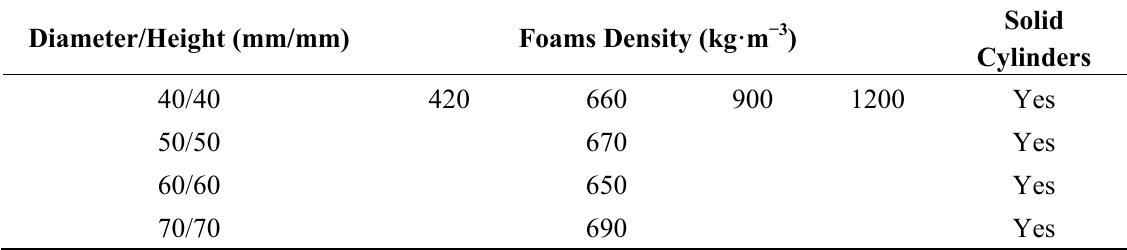
Table 1. Densities and sizes of the samples used in this investigation.